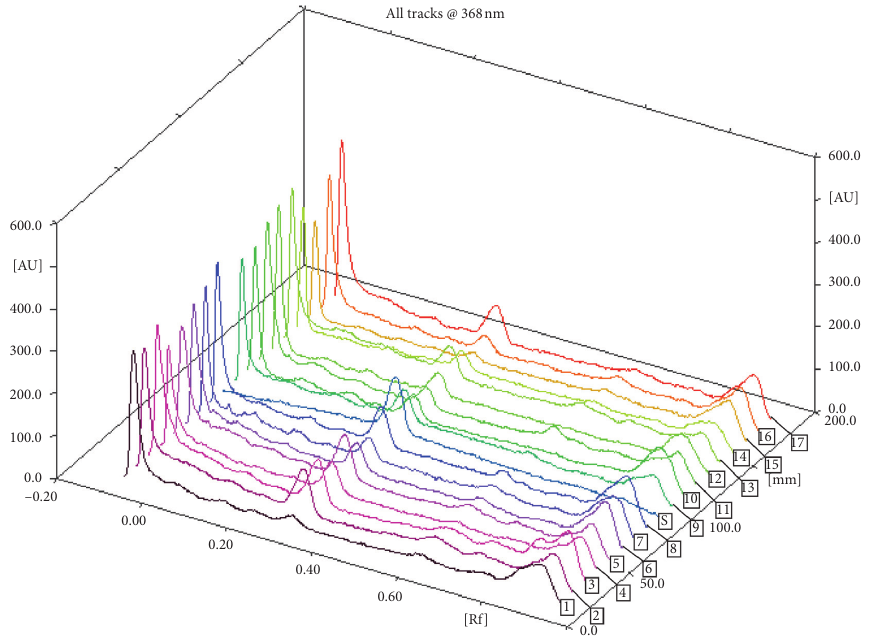
Figure 4: Chromatogram profile of Cassiarin A standard S and samples (numbering as in Table